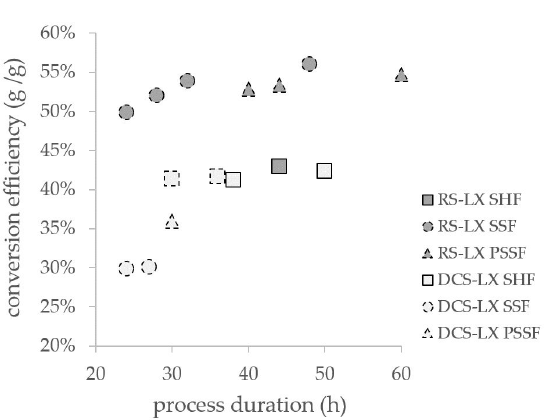
Figure 5. Process performance comparison for separate (SHF, 52 ◦ C and pH 6) and simultaneous (SSF, PSSF, 50 ◦ C and pH 5) fermentation approaches employing B. coagulans 14-300; dashed frames denote fermentation with incomplete sugar consumption (residual xylose).